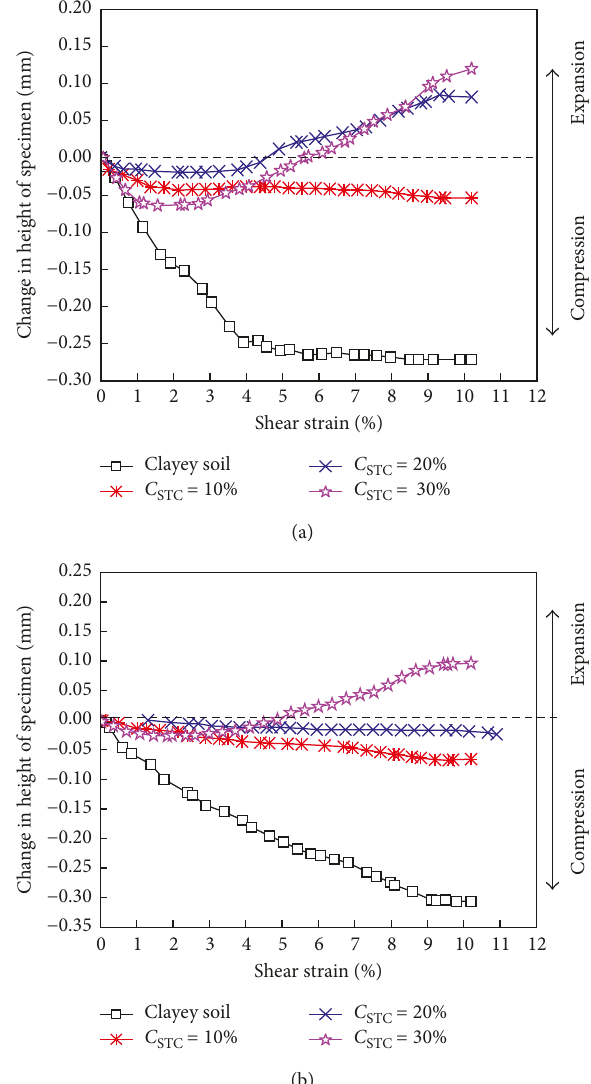
Figure 10: Variations of height of mixtures against shear dis- placement. (a) Under vertical pressure of 50kPa. (b) Under vertical pressure of